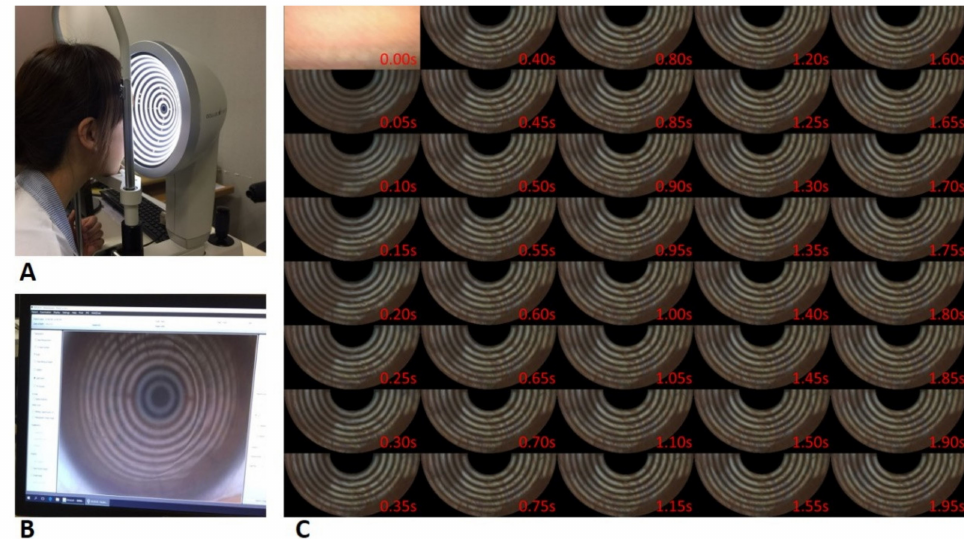
Figure 2. Lipid tear film evaluation by a tear film analyzer, Keratograph 5M. ( A ) Assessment of a subject with the instrument; ( B ) A video with interference colors of the moving lipid tear film is recorded under the white ring light illumination; ( C ) Interference image sequences of lipid layer decomposed from a video record of lipid tear film examination with a time interval of 0.05 s. These interference images reveal dynamic lipid tear film spreading on the ocular surface, especially on the white ring